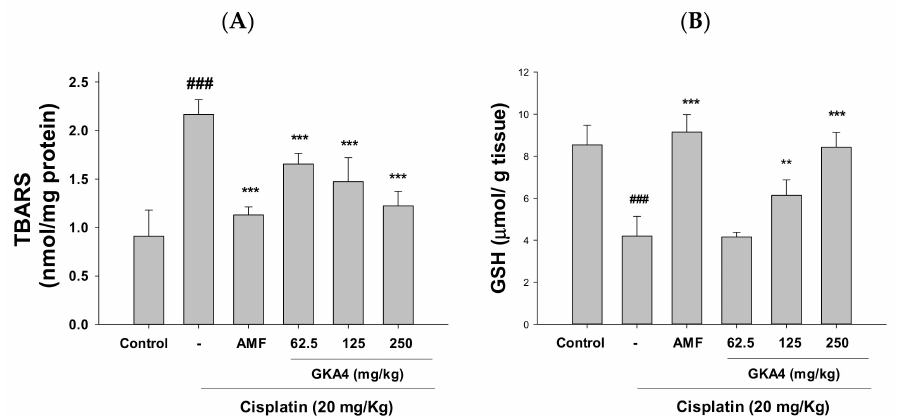
Figure 3. GKA4 avoids oxidative stress against cisplatin-treated AKI. MDA ( A ) and GSH levels ( B ) were measured by MDA and GSH assays. The values were displayed as means ± S.E.M ( n = 5). ### denotes p < 0.001 compared with the sample of the control group. ** p < 0.01 and *** p < 0.001 compared with the cisplatin group. GSH: